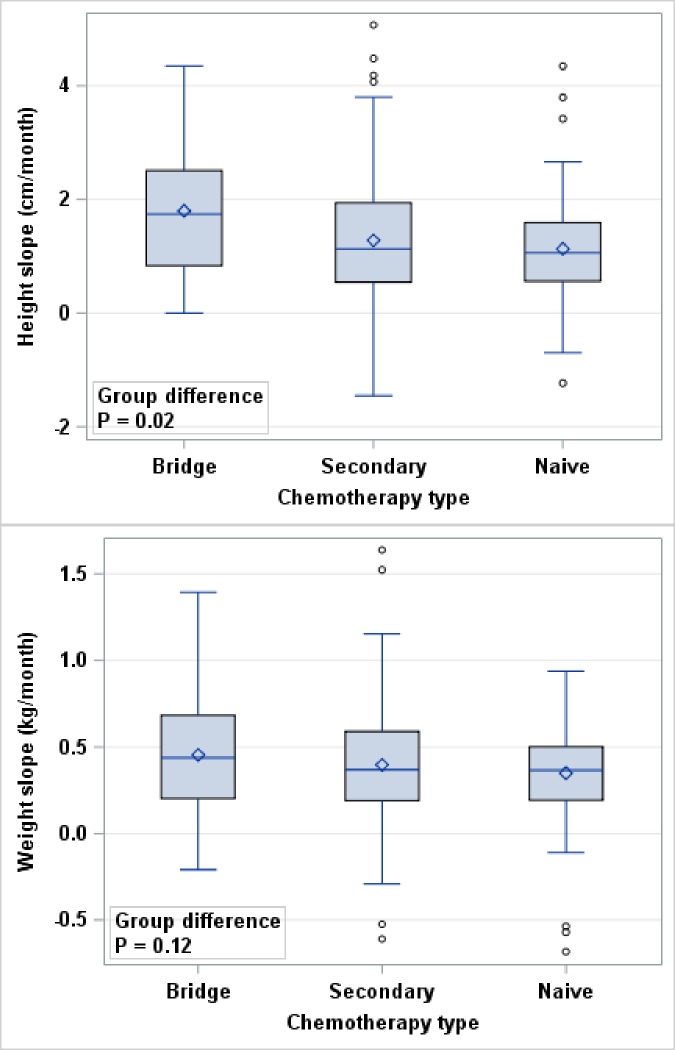
Growth velocity by height and weight during OAC.Growth velocity for height (n = 255) and weight (n = 324) during treatment by chemotherapy group. Growth slope is calculated starting at first treatment and using height and weight measurements up to time of treatment number 4 (or last available measurement prior to treatment 4); slope is calculated for patients who have a measurement available at first treatment and at least one follow-up. Mean height growth is significantly different between groups (ANOVA p = 0.02) with the mean for the bridge group significantly higher than the mean for the naïve group (mean difference: 0.66 cm/month; 95% CI: 0.10, 1.21; p = 0.01). Mean weight growth is not significantly different by group (ANOVA p = 0.12).